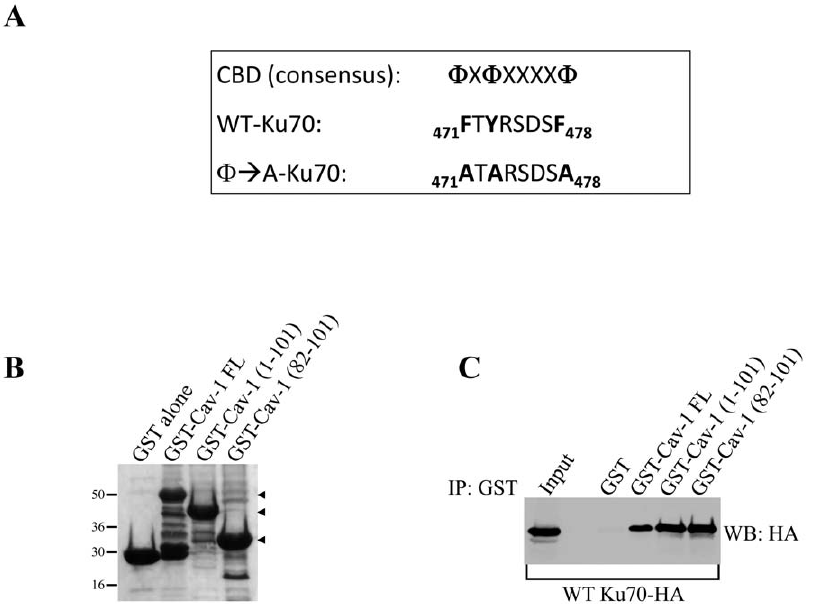
Figure 3. Ku70 binds to the scaffolding domain of caveolin-1. ( A ) The consensus caveolin binding domain (CBD) is shown together with the caveolin binding domain of Ku70 (amino acids 471 to 478) and a mutant form of Ku70’s CBD in which aromatic residues were mutated to alanines. ( B ) Ponceau S staining of GST alone and GST-caveolin-1 fusion proteins. ( C ) GST-caveolin-1 fusion protein pull-down assays were performed using cell lysates from HCT116 cells transiently transfected with wild type Ku70-HA. A blot that is representative of two independent experiments is